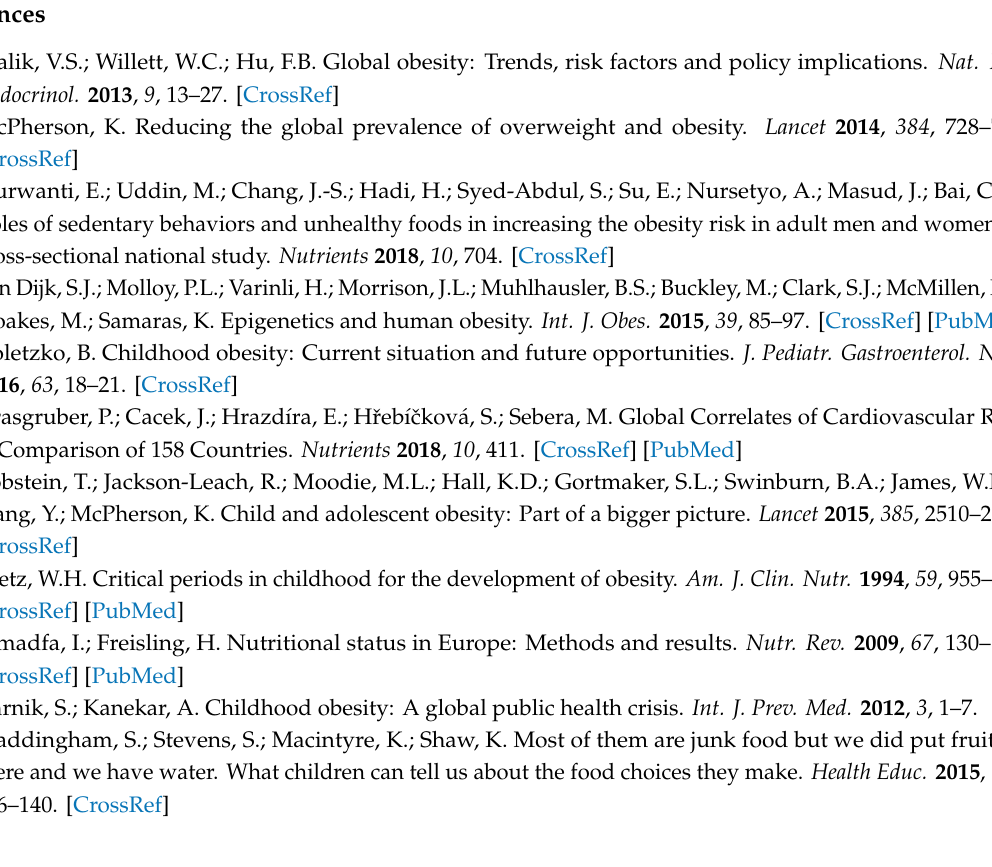
Table S1: Synoptic table of school-feeding policy and regulation based on (EU, 2018). Legend: 1 - there is a recommendation / legislation, Table S2: Structure of participants in preliminary phase of research, Table S3: The socio-economic characteristic features of participants (n =